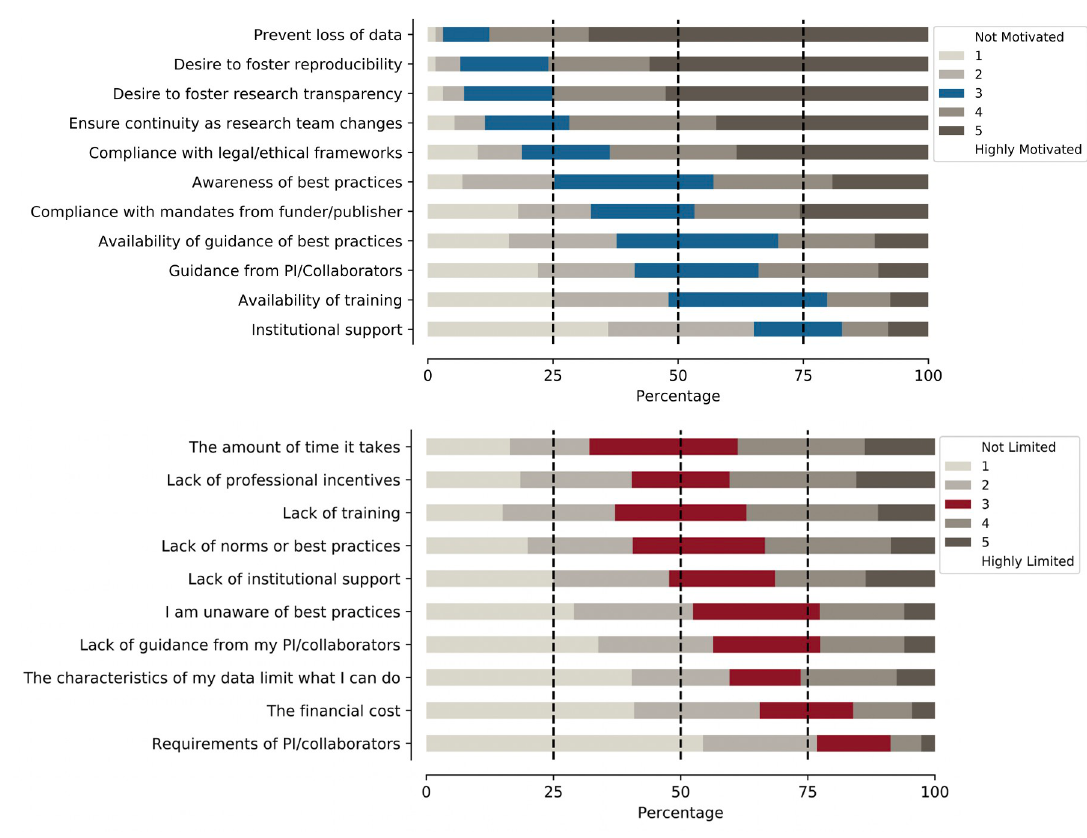
Fig 1. Factors that motivate and limit psychology researchers’ data management practices. Participants were asked to rate the degree to which different factors motivate and limit their data-related practices on a scale of 1 (not limited/motivated) to 5 (highly limited/motivated). For motivations, participants gave high ratings to immediate and practical concerns, such as the desire not to lose data as well as broader concerns such as the desire to foster reproducibility and research transparency. Ratings for limitations were more